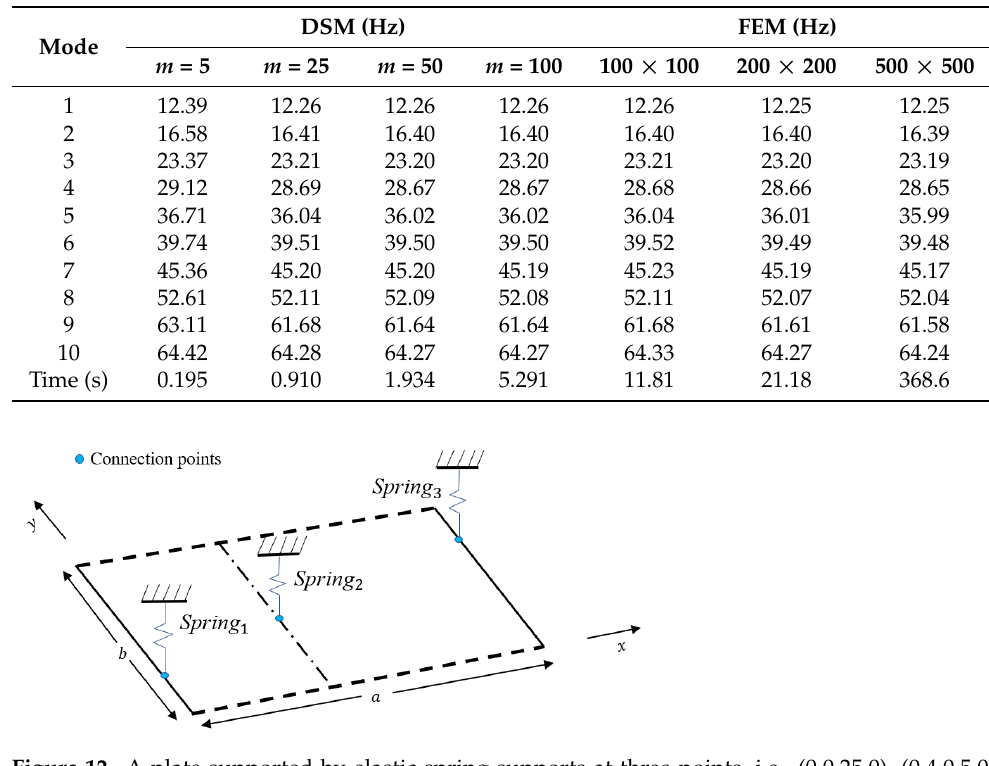
Table 1. The first 10 natural frequencies for a plate supported by three rigid points as shown in Figure 11, by the current DSM with different m , compared with FEM solutions with three different meshes.